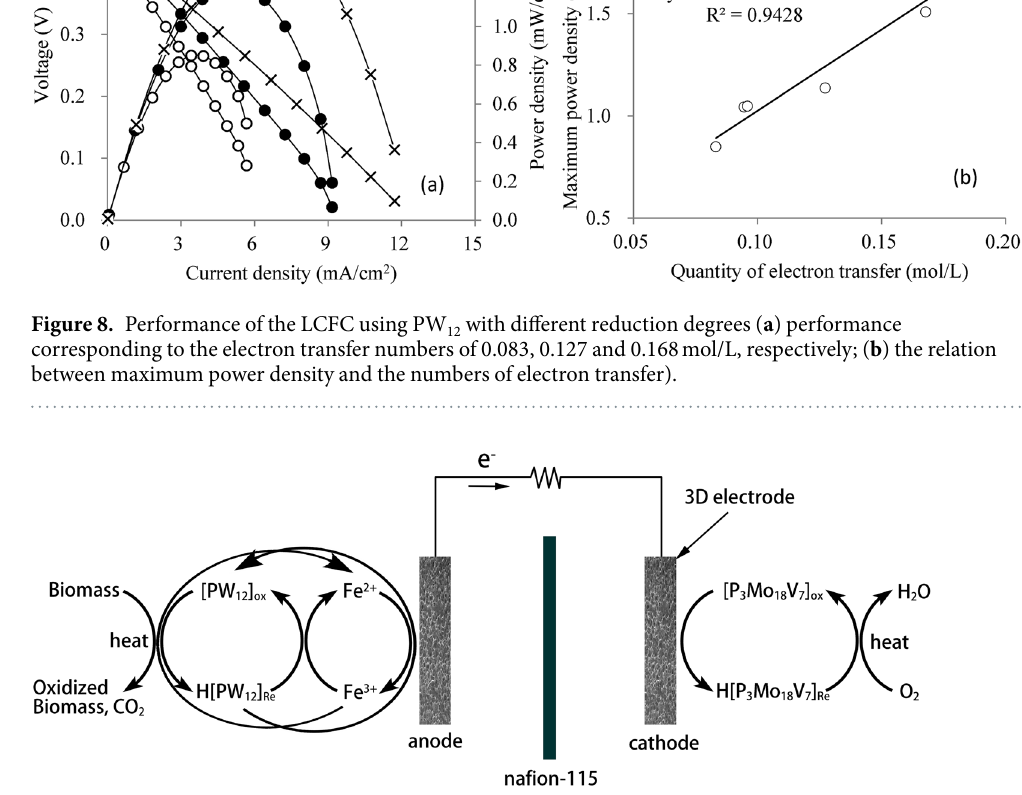
Figure 9. The schematic diagram of FeCl 3 function in